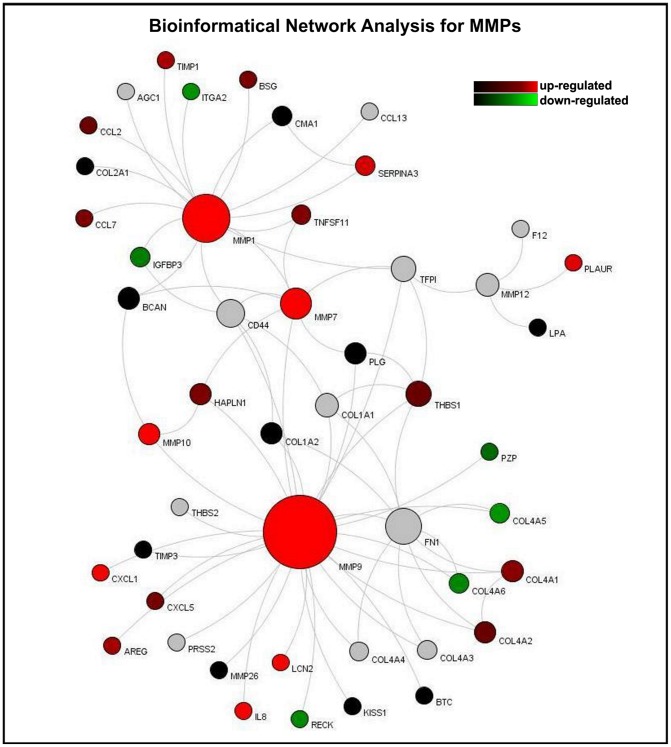
Bioinformatical network analysis for MMPs. Proteins are the nodes and the edges are protein activation/inactivations, such as phosphorylation and dephosphorylation across a set of proteins. The network presented here reveals an up-regulation of the matrix metalloproteinase family members MMP1, 7, 9, 10, 12 as well as LCN2, IL-8 and CXCL1. Down-regulated genes within this network are RECK, COL4A5 and COL4A6. The colors of the nodes describe the regulated expression of genes within cholesteatoma compared to external auditory skin: red: up-regulated genes within cholesteatoma; green: down-regulated genes within cholesteatoma; grey: the gene for the protein is not in the microarray; The “Node Ranking” (Node-Size) describes the number of interactions. The bigger the nodes, the more interactions are represented for the protein in the network.